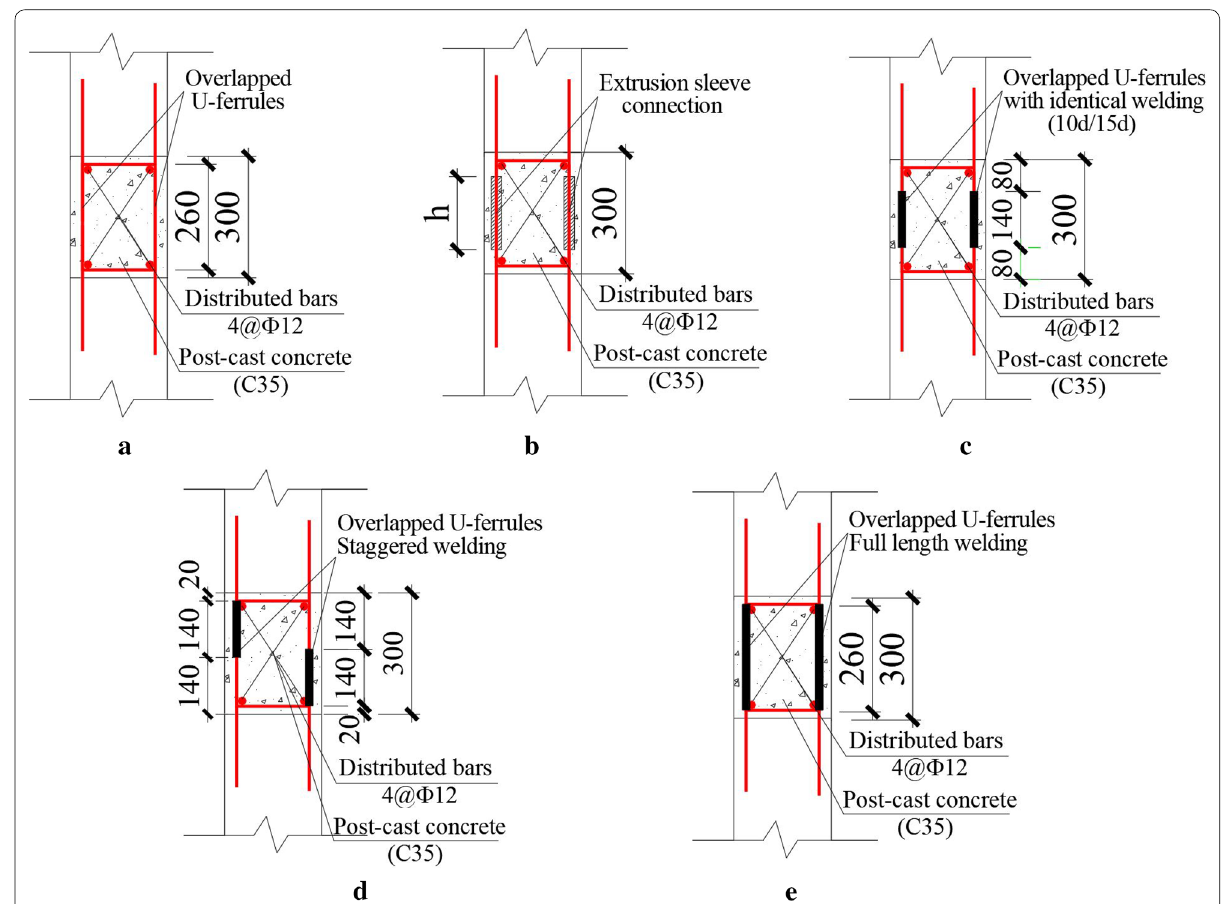
Fig. 3 Construction details of the tested connections: a ZP1; b ZP2; c ZP3/ZP5; d ZP4; e